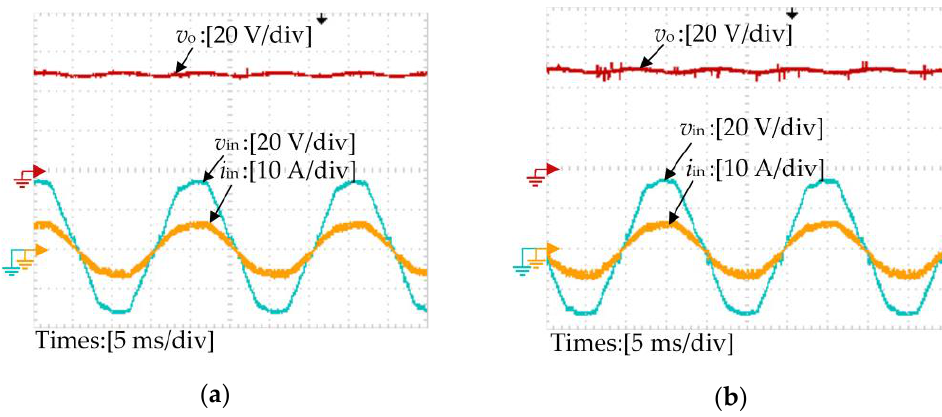
Figure 14. Input voltage and current and output voltage waveforms: ( a ) Regular Boost PFC converter and ( b ) Boost PFC converter with CSS – LS.